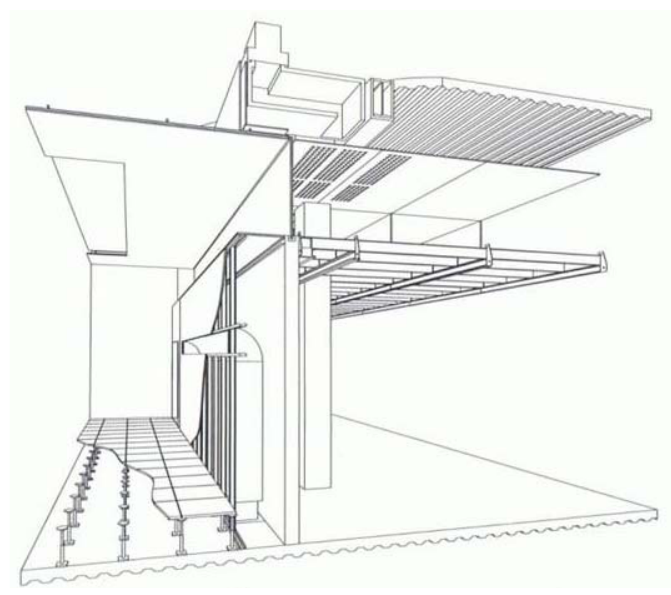
Figure 7. Light Air Duct construction assembly.